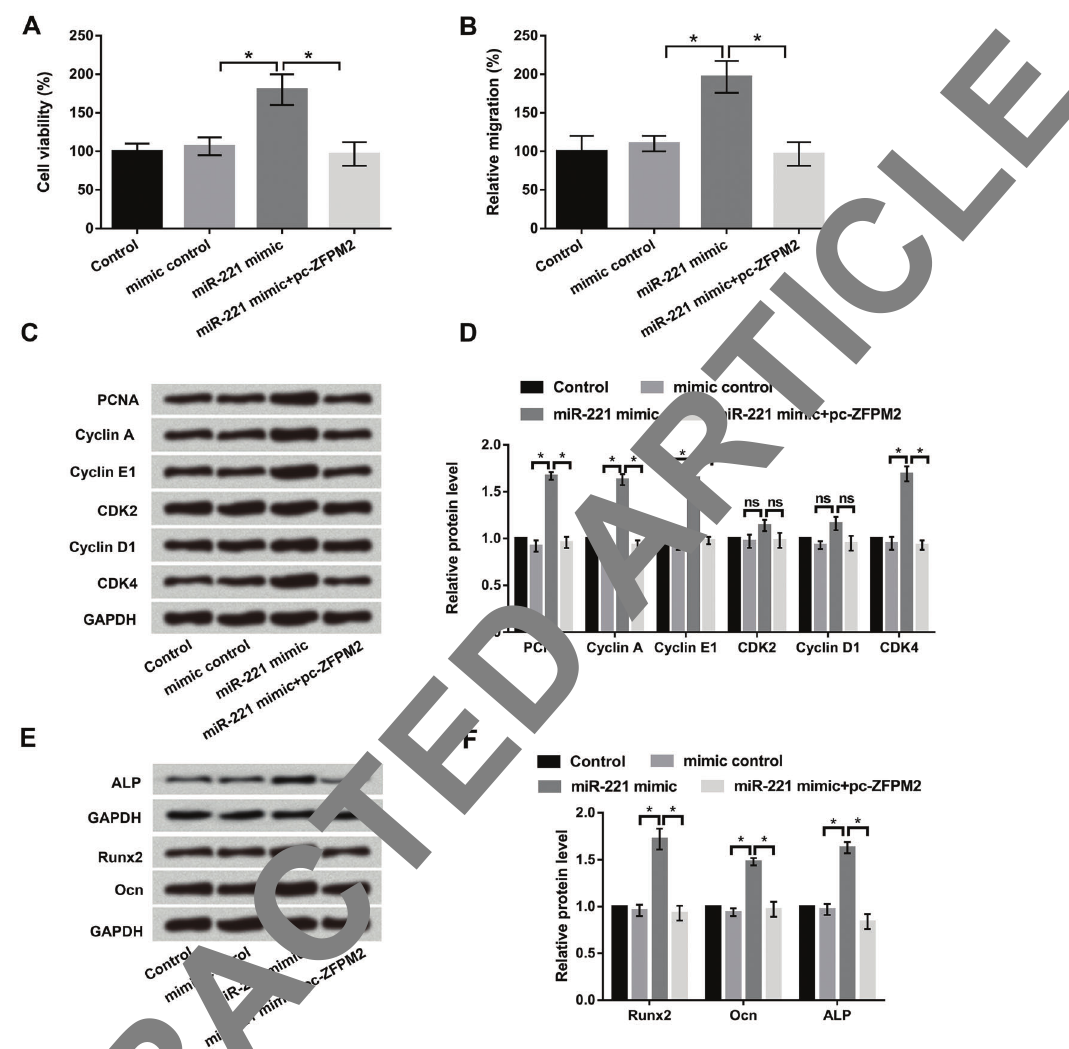
Figure 6. Overexpression of miR-221 promotes osteoblast viability, migration, and differentiation by regulation of ZFPM2. A , Cell viability was measured using the CCK-8 assay. B , Cell migration was measured using the Transwell migration assay. C and D , Protein levels of cell cycle-related proteins were measured using western blot. E and F , Protein levels of differentiation-related proteins were detected by western blot. miR-221: microRNA-221; ZFPM2: zinc fi nger protein multitype 2; CCK-8: cell counting kit-8; PCNA: proliferating cell nuclear antigen; CDK: cyclin-dependent kinase; ALP: alkaline phosphatase; Runx2: runt-related transcription factor 2; Ocn: osteocalcin. Data are reported as means ± SD. *P o 0.05 (ANOVA). ns: not signi fi